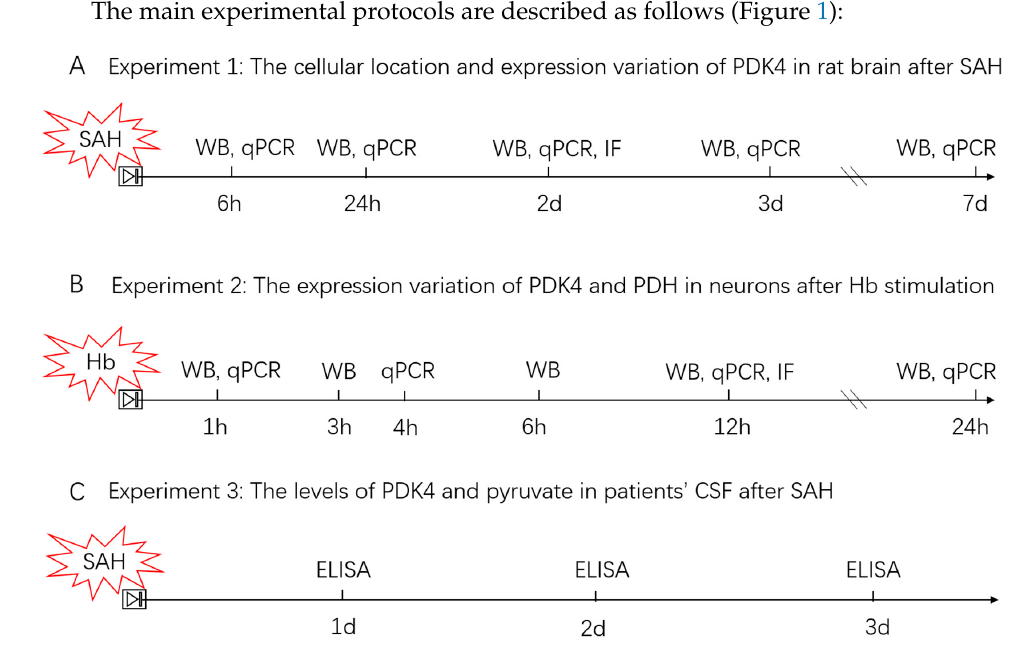
Figure 1. The experimental designs and groups. The experimental designs in vivo ( A ), in vitro ( B ), and in SAH patients’ CSF ( C ). WB, western blotting; qPCR, quantitative real-time polymerase chain reaction; IF, immunofluorescence staining; h, hours; d, days; SAH, subarachnoid hemorrhage; Hb, hemoglobin; CSF, cerebrospinal